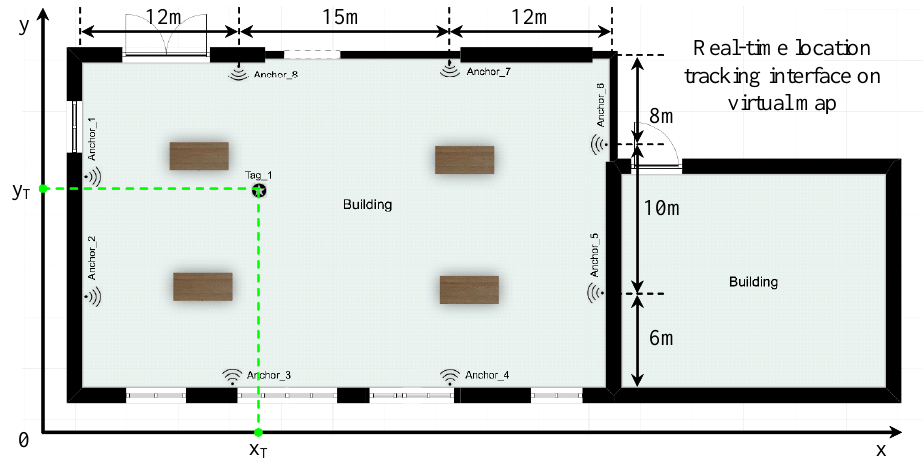
Figure 8. Real-time location tracking interface on virtual map, PC of